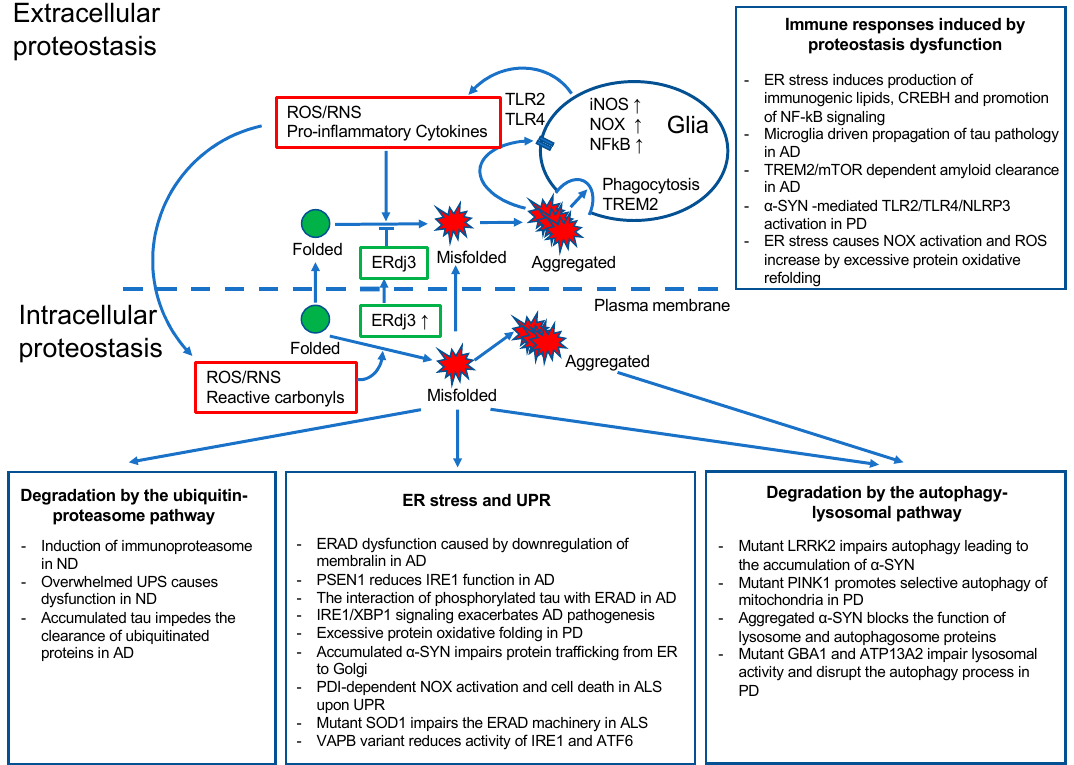
Figure 1. The extracellular and intracellular proteostasis in neurodegenerative diseases. Scheme representing proteostatic dysfunction in neurodegenerative diseases and the associated link between proteostasis and the inflammatory response. ND, neurodegenerative diseases; NF-kB, nuclear factor kappa-light-chain-enhancer of activated B cells; ERdj3, endoplasmic reticulum DnaJ homologue; TREM2, triggering receptor expressed on myeloid cells 2.